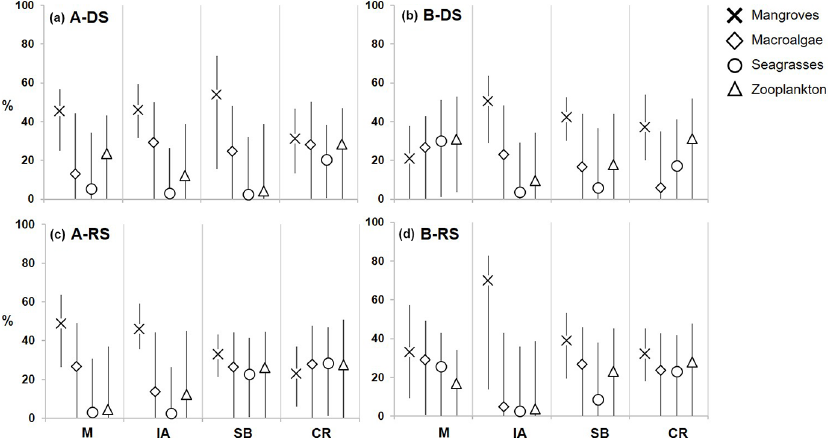
Figure 5. Organic matter source probability of contribution (mode ± 95th credibility interval) to SPOM in the four sampling stations (man- grove forest, M; intertidal area, IA; seagrass bed, SB; coral reef, CR) along transects A and B in dry (DS) and rainy season (RS). Mangroves (cross), macroalgae (diamond), seagrasses (circle) and zooplankton (triangle).